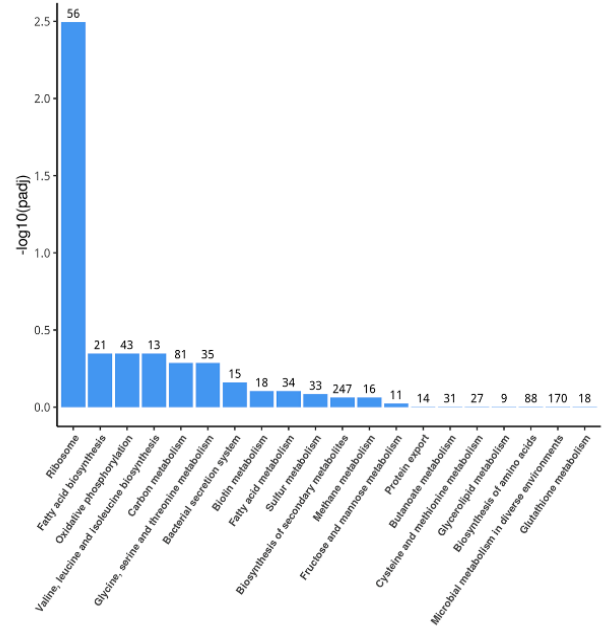
Figure 4. Histogram of KEGG enrichment analysis. Table 2. Partial results of KEGG enrichment analysis (top